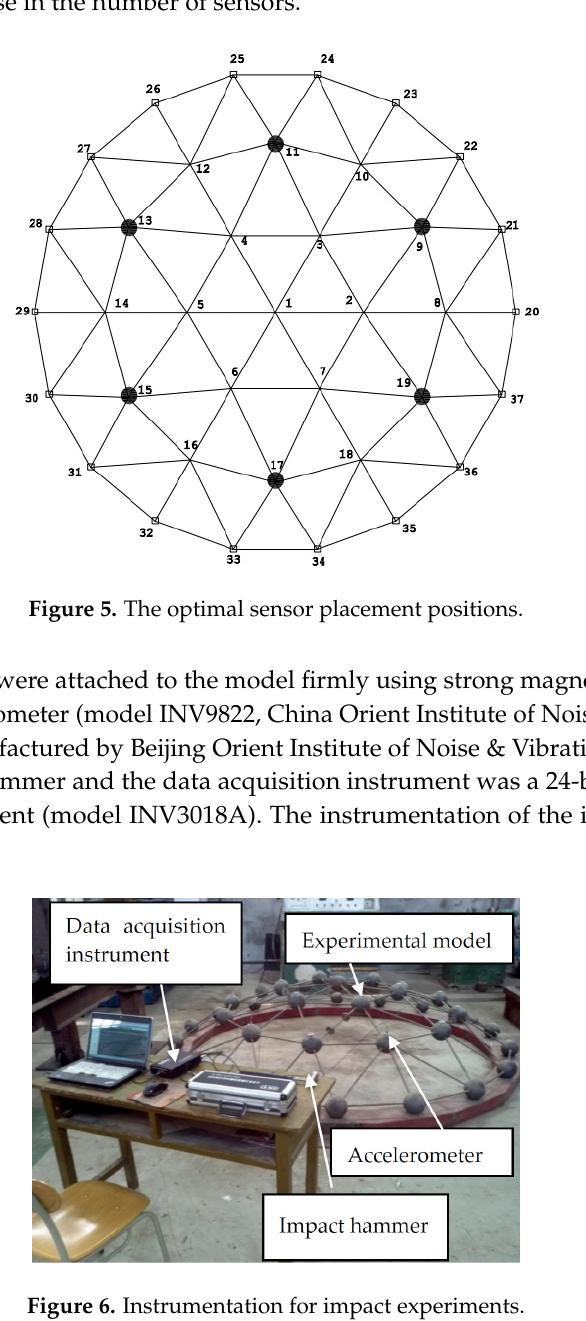
Figure 6. Instrumentation for impact experiments.